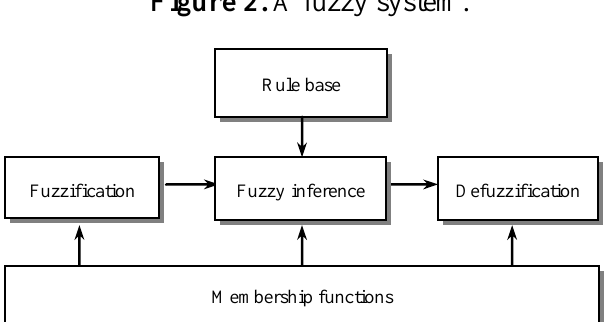
Figure 2. A fuzzy